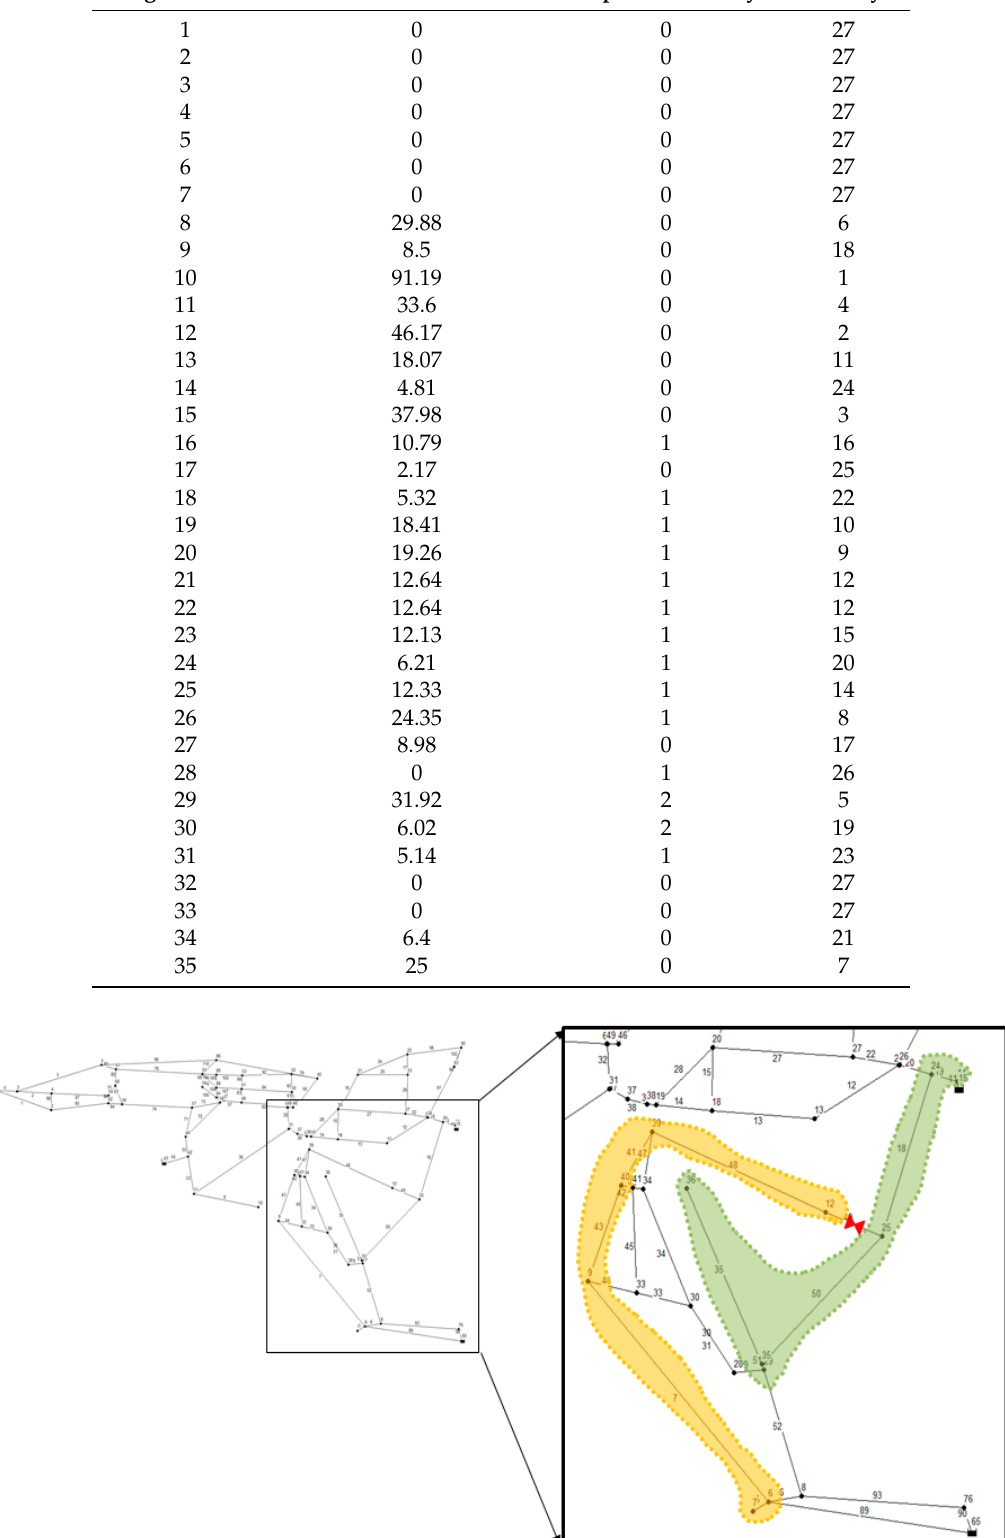
Figure 9. Result of optimal valve installation for segment division.